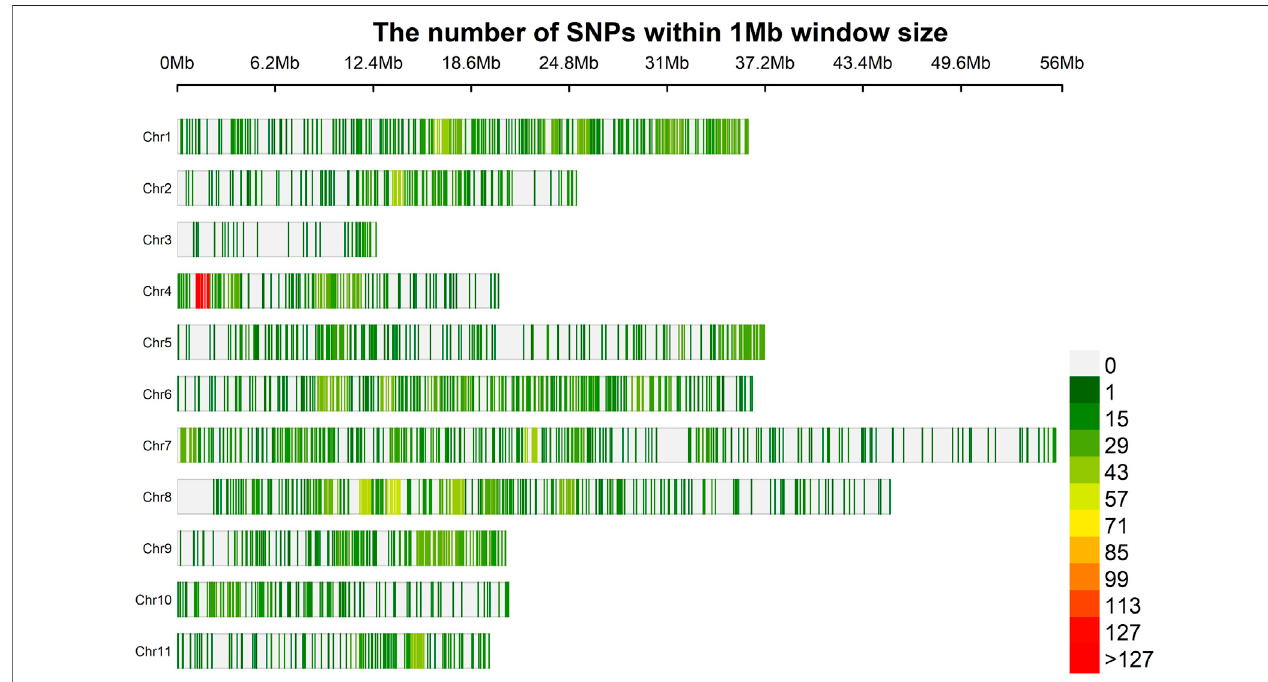
FIGURE 3 | Population structure of 100 blackgram germplasm lines using 4623 SNP markers (A) determination of number of sub-populations by DeltaK method byEvannoetal.,2005 (B) determinationofnumberofsub-populationsusingcrossentropyvaluemethodbyChanandKroese,2012 (C) populationstructureatk=4 (D) phylogenetic analysis of 100 blackgram germplasm lines depicting four sub-populations.